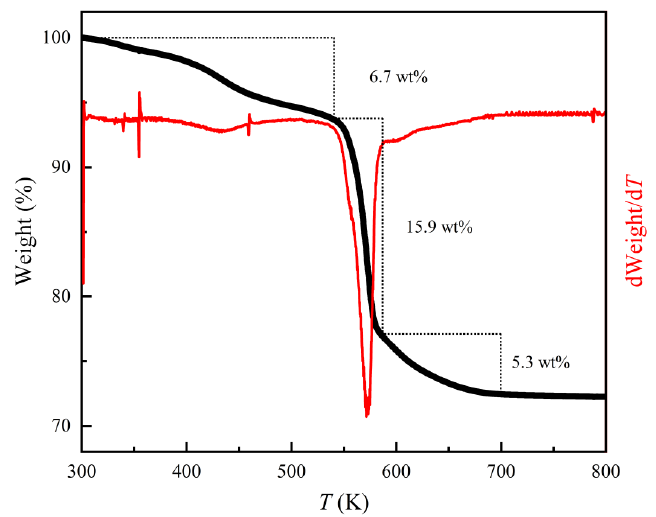
Figure 3. TGA and dWeight/d T curves of the (Fe 2 Se 3 ) 2 [Fe(dien) 2 ] 0.9 hybrid rods. Powder XRD pattern of the hybrid rods (Figure 4) reveals that all Bragg diffraction peaks can be refined and indexed by using the monoclinic structure with the space group P2 1 /c (14). The corresponding refinement process gave good R factors ( R p = 8.52%, R wp = 7.45% and χ 2 = 2.72), and refined room-temperature lattice parameters of the hy- brid material are a = 11.397(7) Å , b = 19.376(3) Å , c = 11.185(6) Å and β = 105.04°. The crystal structure of the hybrid rods is the same as that for Fe 3 Se 4 (tren) (tren = tris(2- aminoethyl)amine) [13] but different from those for previous orthorhombic Fe 3 Se 4 (dien) 2 [13] and iron vacancy doped (Fe 0.86 Se 2 ) 2 Fe(dien) 2 [22], in which two independent subsys- tems have been identified: 1D FeSe 2 chains and Fe(dien) 2 complex. Because two dien molecules with six nitrogen atoms have bonded well with a Fe 2+ to form a [Fe(dien)]